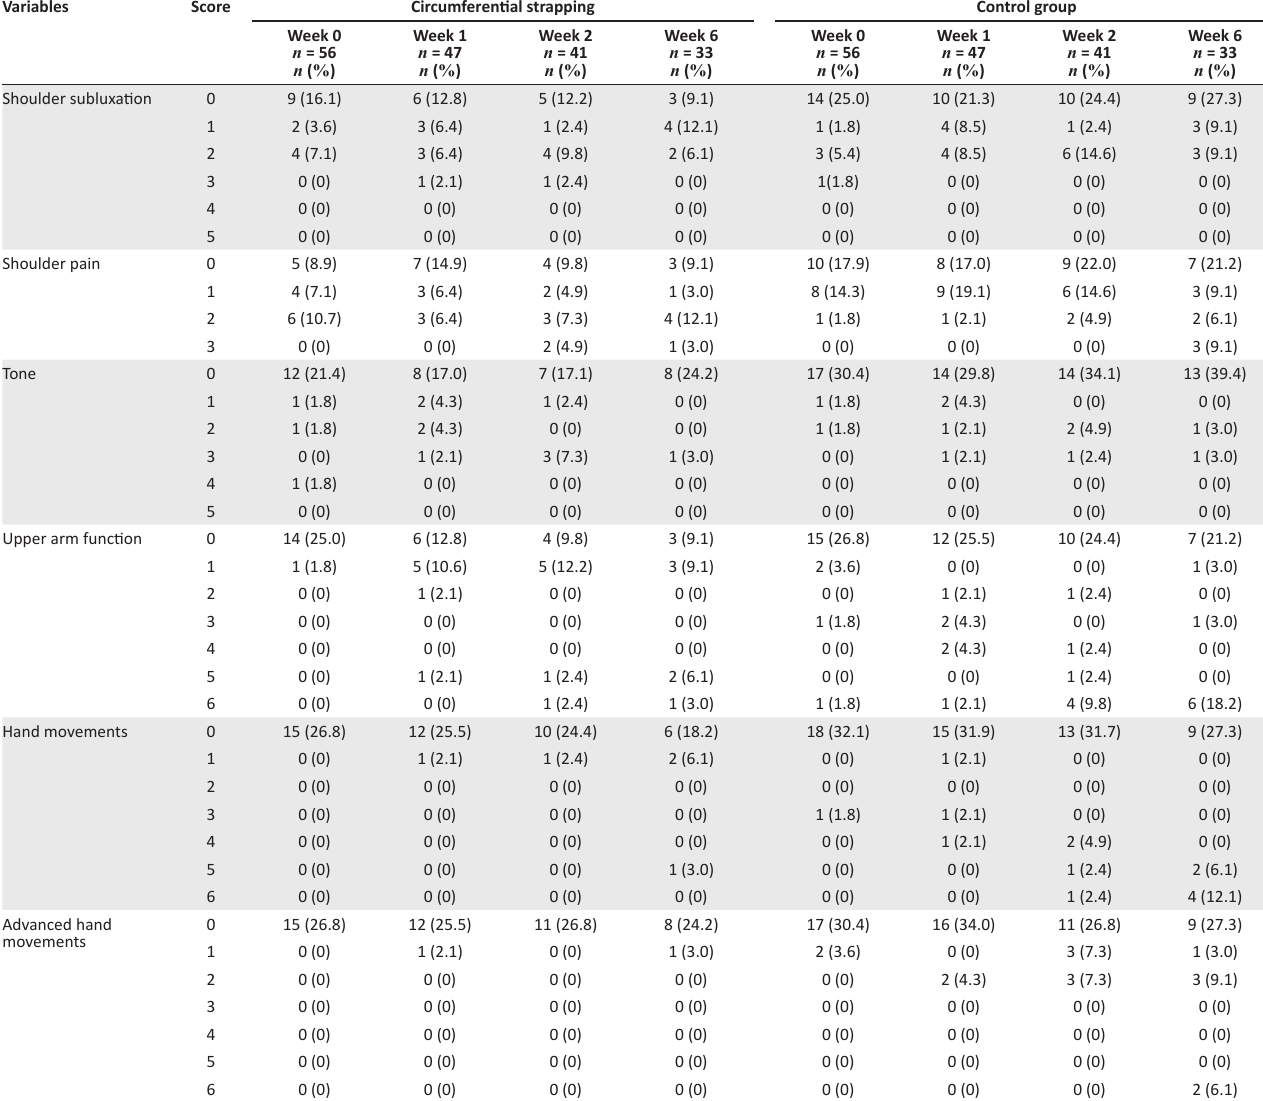
TABLE 5: Changes in outcomes between the circumferential strapping and the control group over a 6-week period. Variables Score Circumferential strapping Control